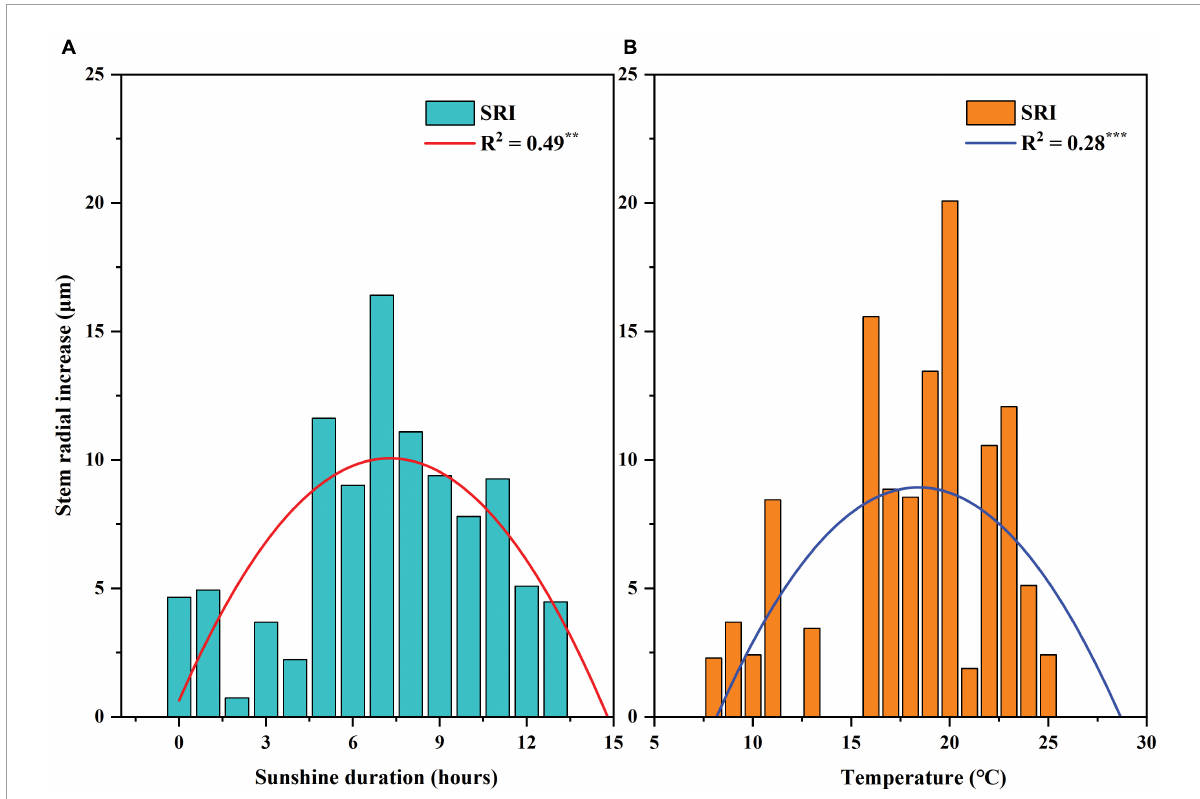
FIGURE7 Changes in the intra-annual stem radial growth with sunshine duration (A) and temperature (B) of L. principis-rupprechtii . The bars represent the variation of L. principis-rupprechtii on different gradients of climate factors. The blue and red parabolas are fitted curves of the trends in 2021. Significance levels (*** p < 0.001, ** p <